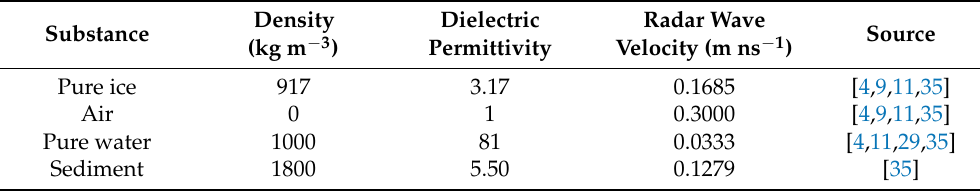
Table 2. Density, dielectric permittivity, and radar wave velocity of each phase